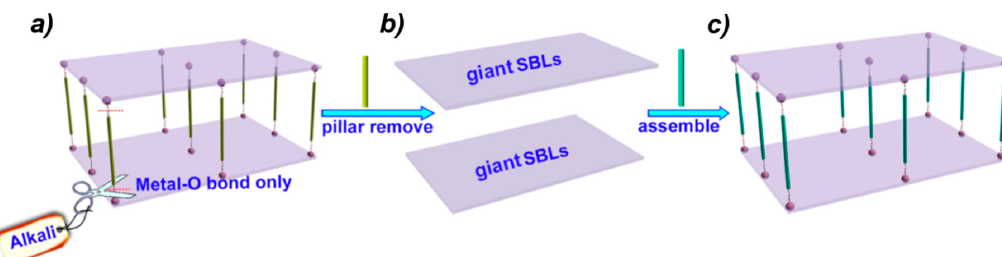
Figure 6. ( a ) A metal–organic framework composed of sheets of Zn–azolate bonds pillared by